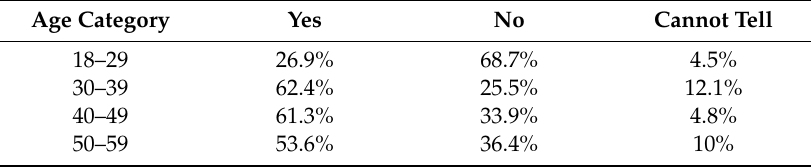
Table 4. Cross tabulation statistics on age and house ownership.